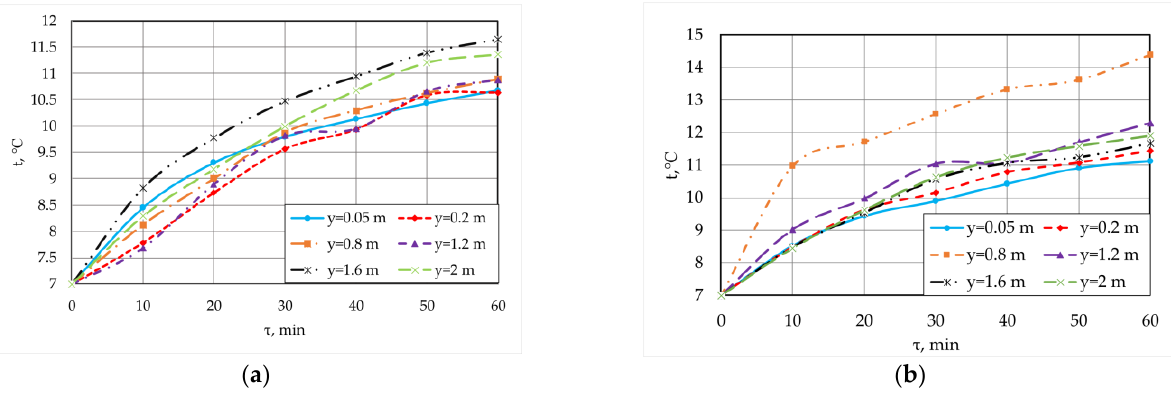
Figure 3. Air temperatures change with increasing time at the points of thermocouples ’ location on the GIH symmetry axis: ( a ) premises without equipment; ( b ) the panel is located at a height of 0.755 m from the floor.